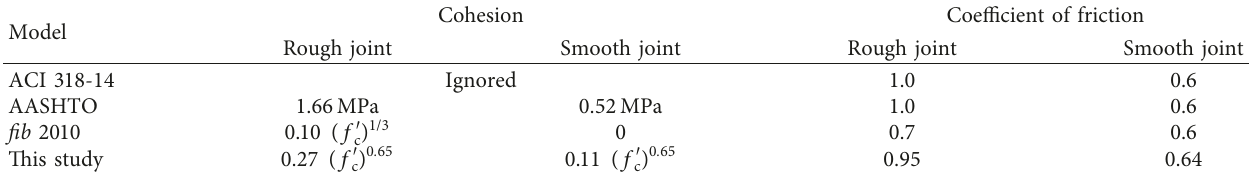
Table 1: Comparison of cohesion and frictional coefficients of concrete in each